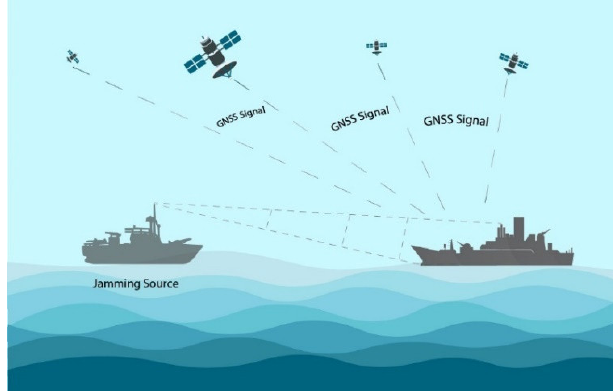
Figure 1. Illustration of a jamming source attack on a warship .